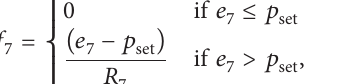
each other to avoid mutual contamination. From the energy conversion point of view, the left oil cylinder functions more like a pump with linear motion. The fully detailed working principle of this ERS could be referred to as in the previous paper